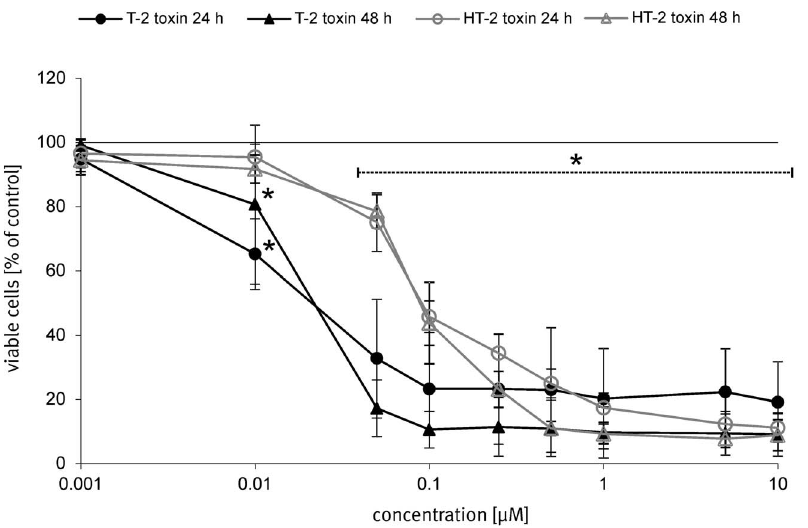
Figure 2. Influence of T-2 and HT-2 toxin on cell viability of PBCEC. Cell viability of PBCEC depending on different T-2 and HT-2 toxin concentrations (1 nM – 10 m M) after 48 h incubation was determined by the CCK-8 assay. Number of analyzed samples n =18 over three individual preparations. Data is given as mean 6 SEM.